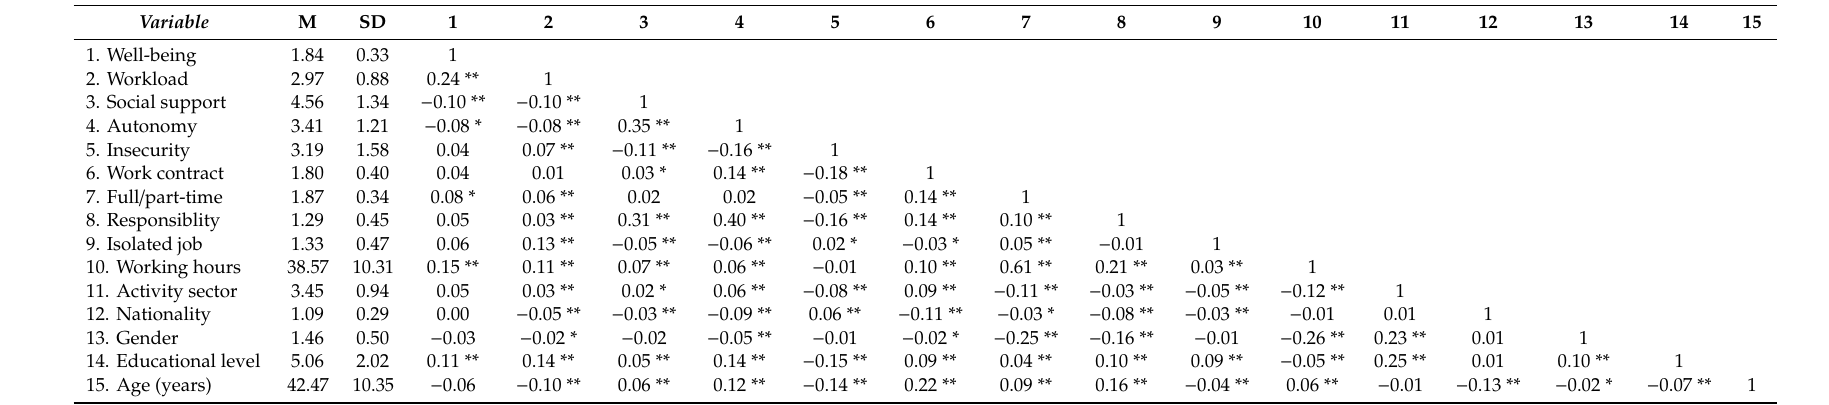
Table 4. Means, standard deviation and intercorrelations of the variables used in this study (n =